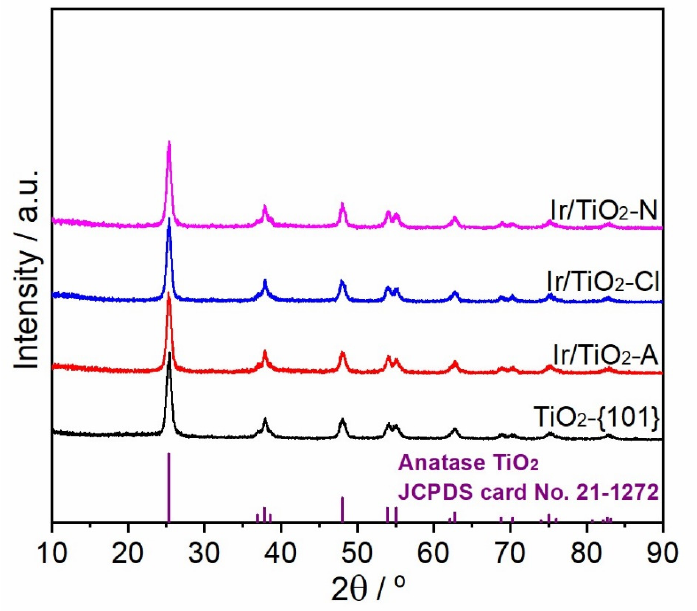
Figure 1. XRD patterns of fresh TiO 2 -{101} NCs and pre-reduced Ir/TiO 2 catalysts.